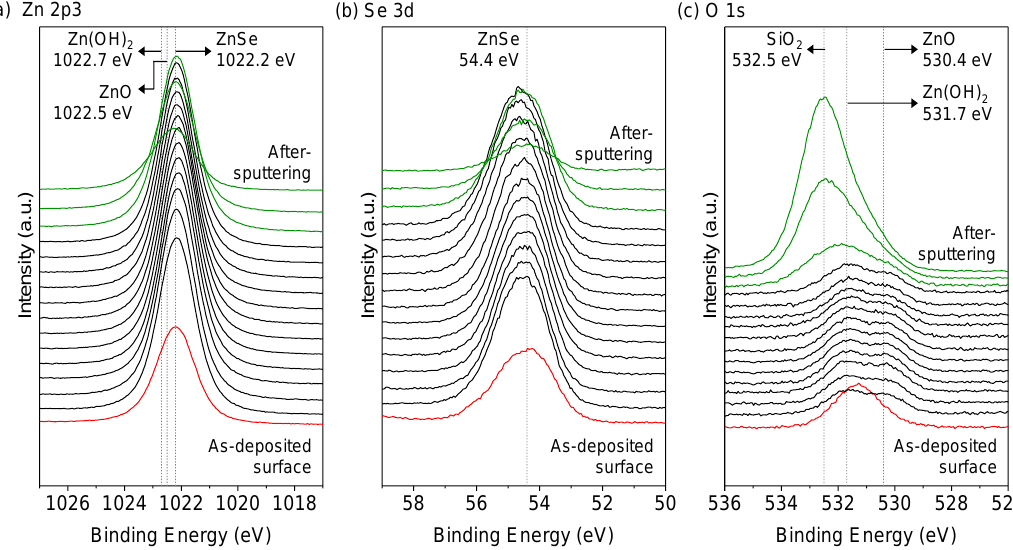
Figure 8. Montage of photoelectron binding-energy spectra for the depth profiles of Zn 2p3, Se 3d, and O 1s of a Zn(Se,OH) film, deposited with selenourea concentration of 0.045 M (view with after-sputtering curve in the background).